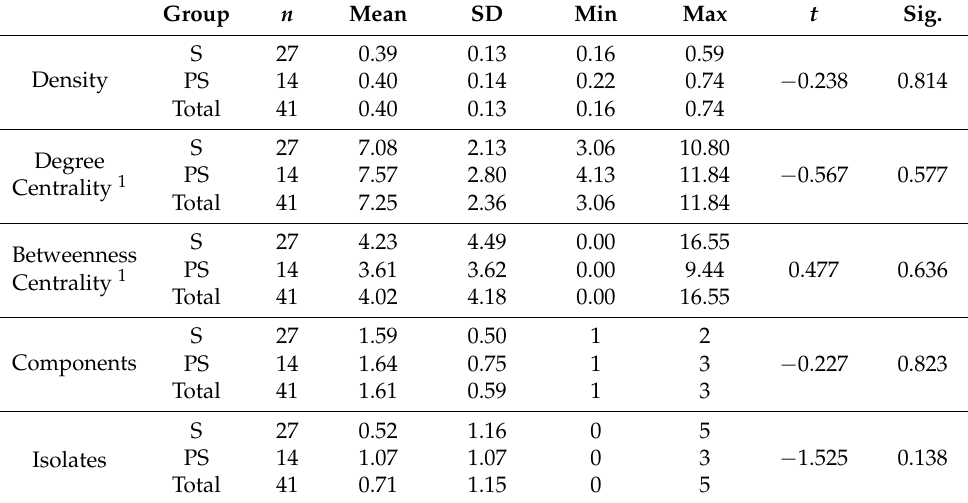
Table 3. Personal network structure variables by groups.